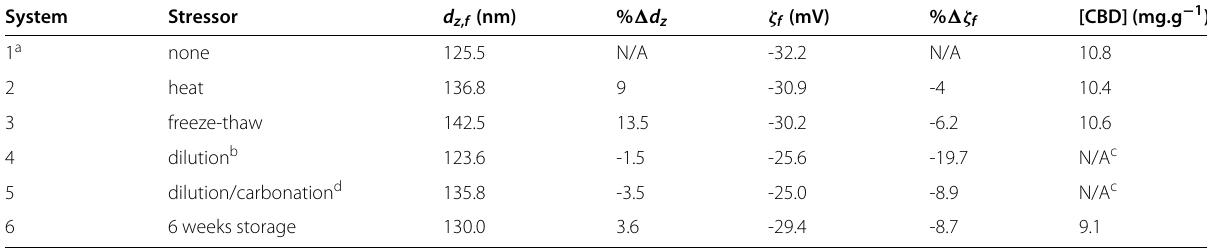
Table 2 Impact of stressors on optimized CD CBD nanoemulsion parameters System